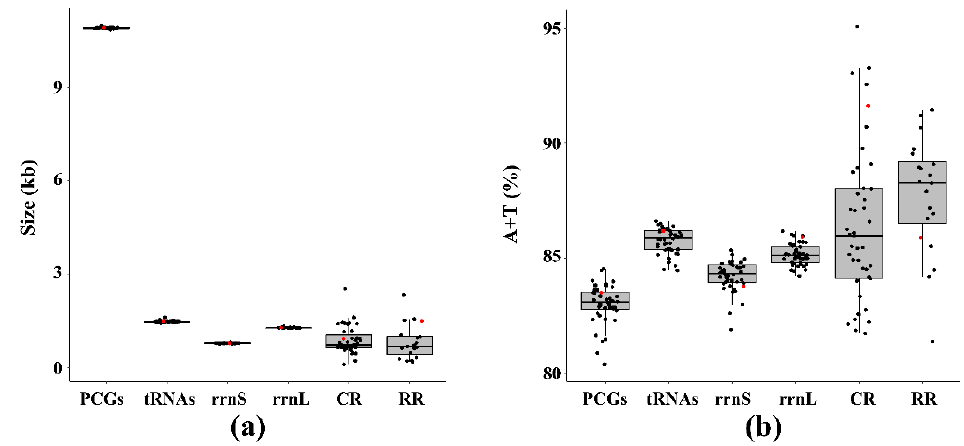
Figure 2. The size ( a ) and AT content ( b ) of PCGs, rrnL , rrnS , CR and RR of 44 aphid species with the red dots representing the Stomaphis sinisalicis . Lower edge of the gray rectangle, 25 percentile; central black bar within the rectangle, median; upper edge of the rectangle, 75 percentile.